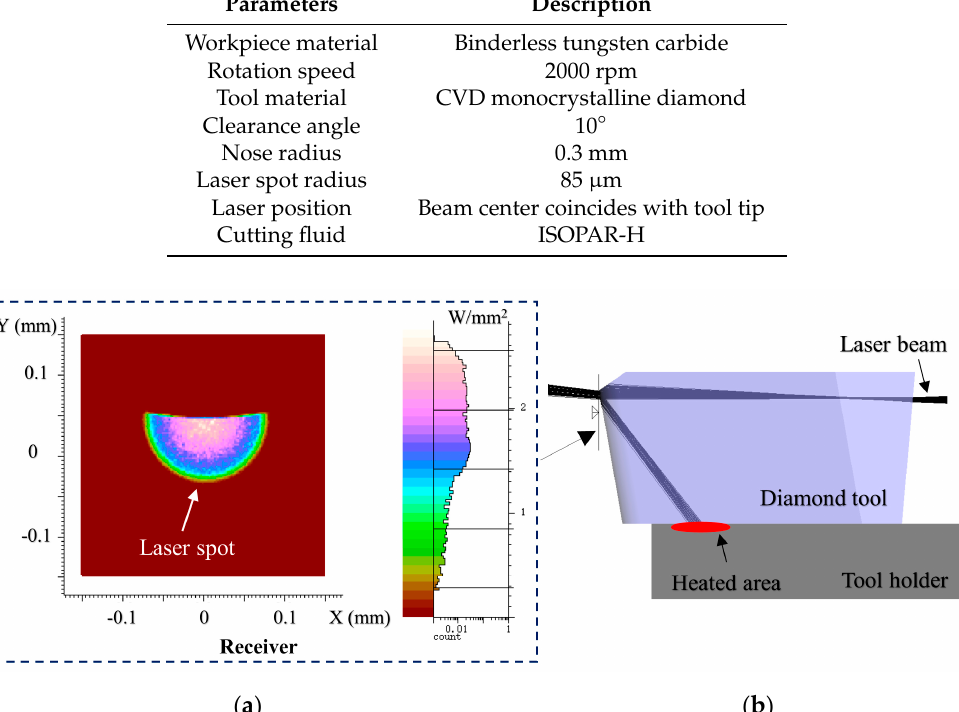
Figure 4. Optical simulation results. ( a ) Emitted laser spot from diamond tool and ( b ) laser beam path in the In-LAT diamond tool.